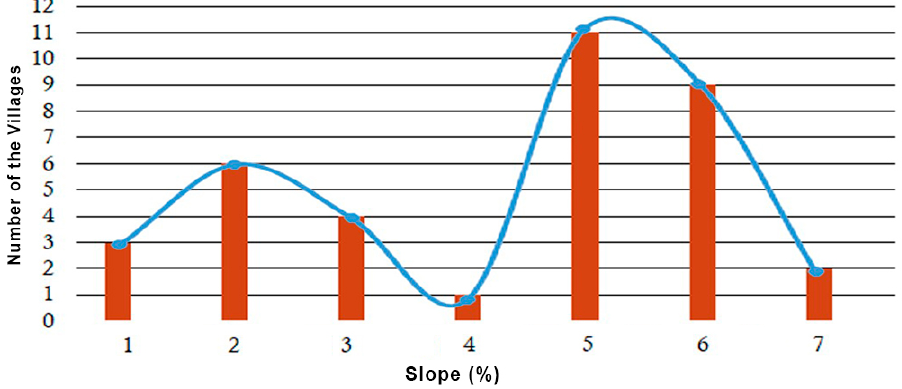
Figure 4. The histogram for the “Slope” index.